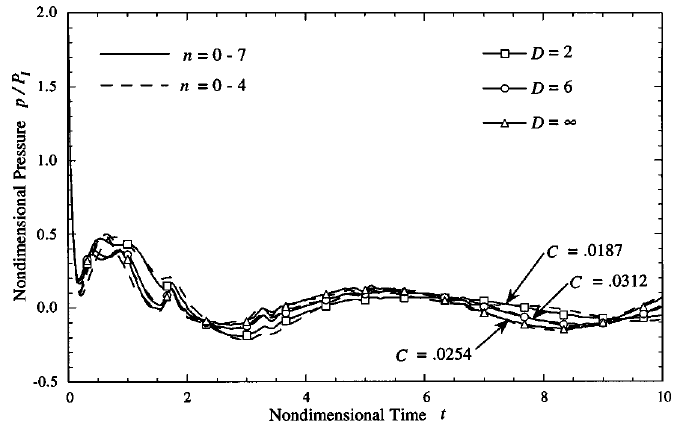
Fig. 7. External-surface pressure histories at (cid:18) = (cid:25) for an empty spherical shell excited by spherical step-exponential waves ( (cid:12) =